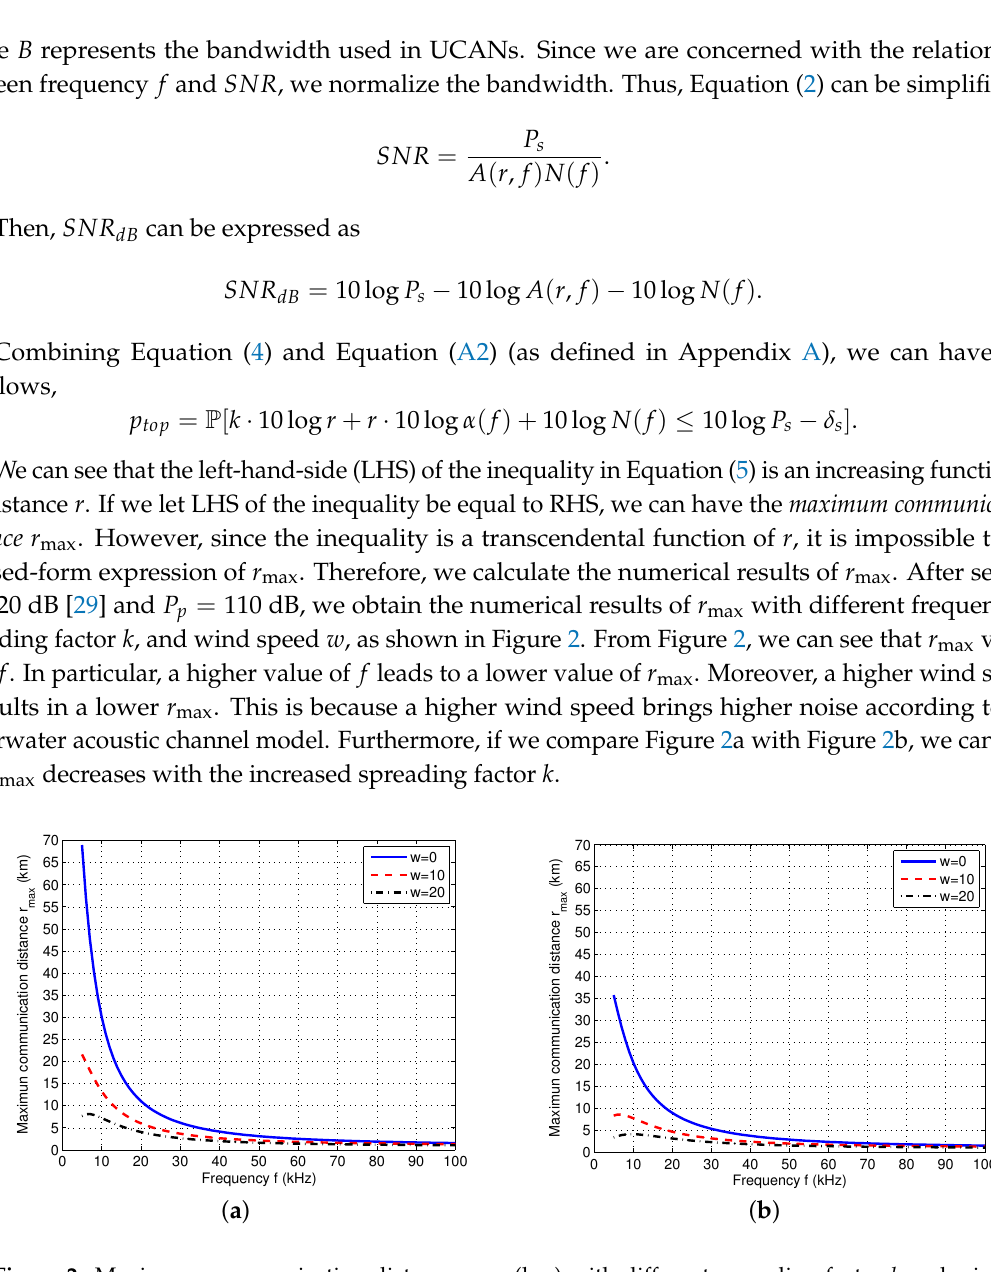
Figure 2. Maximum communication distance r max (km) with different spreading factor k and wind speed w (m/s) when s = 1, P s = 100 dB, and δ s = 20 dB. ( a ) k = 1; ( b ) k =